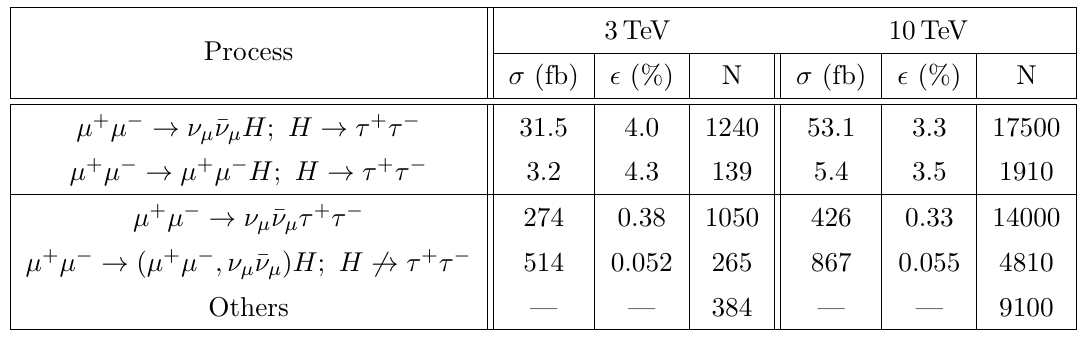
Table 2 . Signal and most important backgrounds for combined VBF H → τ + τ − after applying τ -tagging and analysis cuts. Here “Others” consists of s -channel and VBF diboson production, tb , and t ¯ t